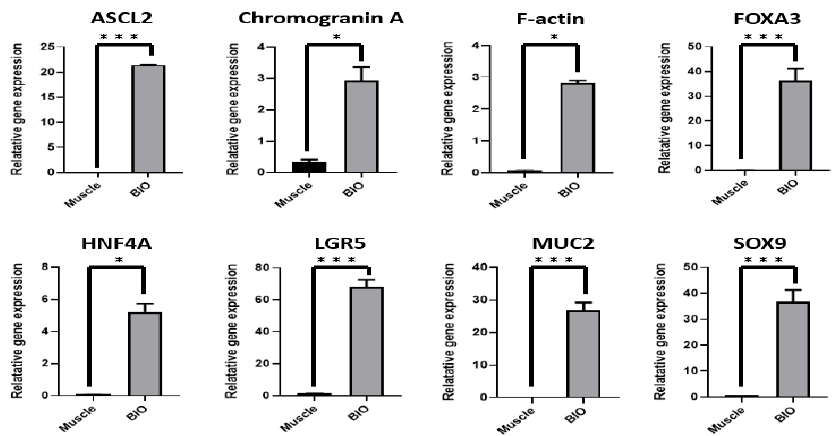
Figure 5. Gene expression profiling of bovine intestinal organoids using quantitative RT-PCR. Quantitative RT-PCR was performed to evaluate gene expression of bovine intestinal organoids (BIO) using several markers of intestinal stem cells ( LGR5 , ASCL2 , HNF4A , FOXA3 , and SOX9 ) and epithelium ( MUC2 , Chromogranin A , and F-actin ) characteristics with muscle from adult bovine as a control. Gene expression was normalised to that of 18S rRNA and analysed by the 2 − ∆∆ Ct method. Significant differences between groups were analysed by Student’s t -test. A p value less than and equal to 0.05 indicated statistical significance (* p value ≤ 0.05, ** p value ≤ 0.01, *** p value ≤